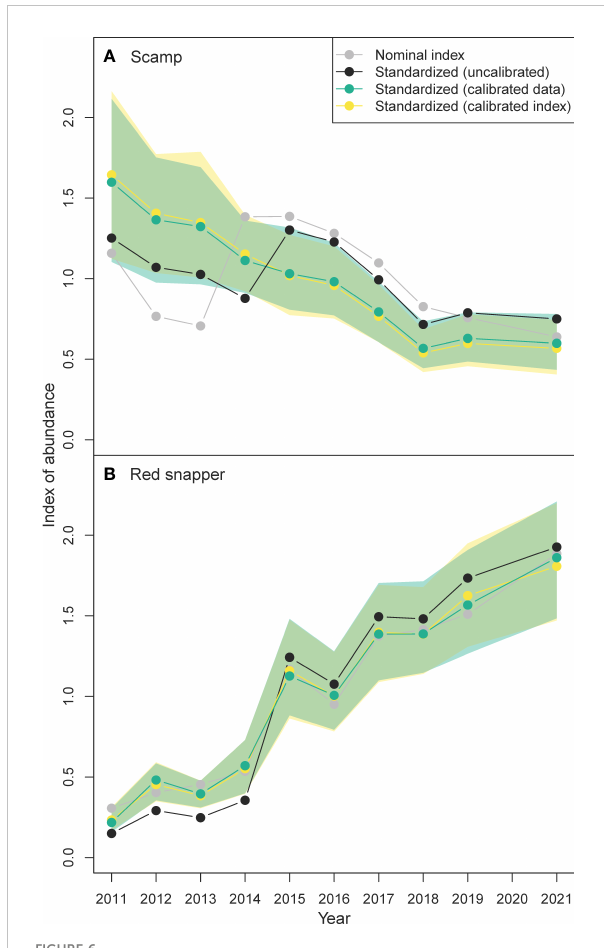
FIGURE 6 Indices of abundance for (A) scamp Mycteroperca phenax and (B) red snapper Lutjanus campechanus calculated four different ways: (1) a nominal index where no standardization or calibration occurred (gray fi lled points and line), (2) a standardized index that did not include calibration for a camera switch that occurred between 2014 and 2015 (black fi lled points and line), (3) a standardized index that included video data that were pre-calibrated before inclusion in a standardization model (blue-green fi lled points, line, and shaded 95% con fi dence interval), and (4) a standardized index that was post-calibrated at the index level (yellow fi lled points, line, and shaded 95% con fi dence interval). Overlapping 95% con fi dence intervals are shown in